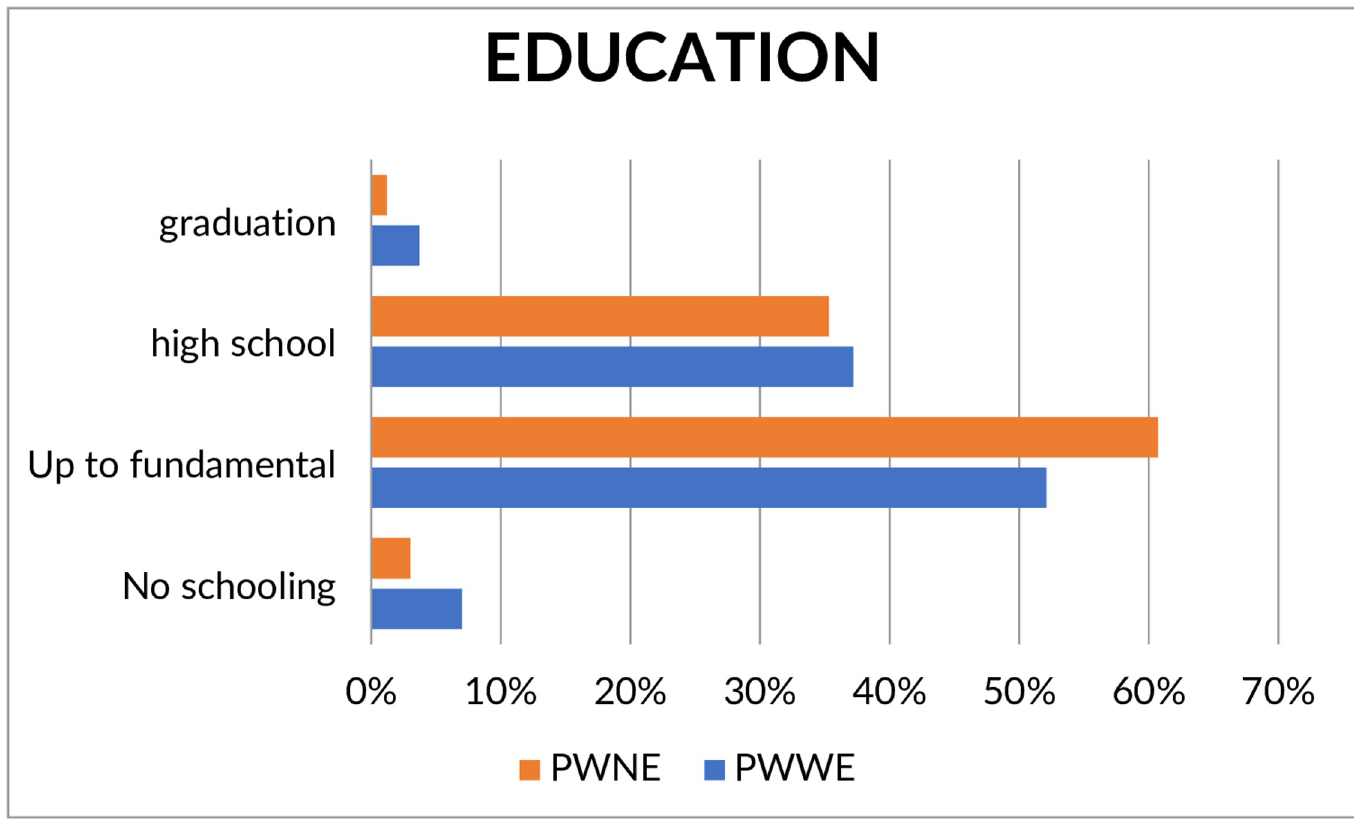
Fig 1. Comparison of average in education variables between pregnant women with and without epilepsy. The figure shows the proportion of pregnant women without epilepsy with complete or incomplete primary education and that of pregnant women with epilepsy that were illiterate, had complete or incomplete high school level, and complete or incomplete graduation